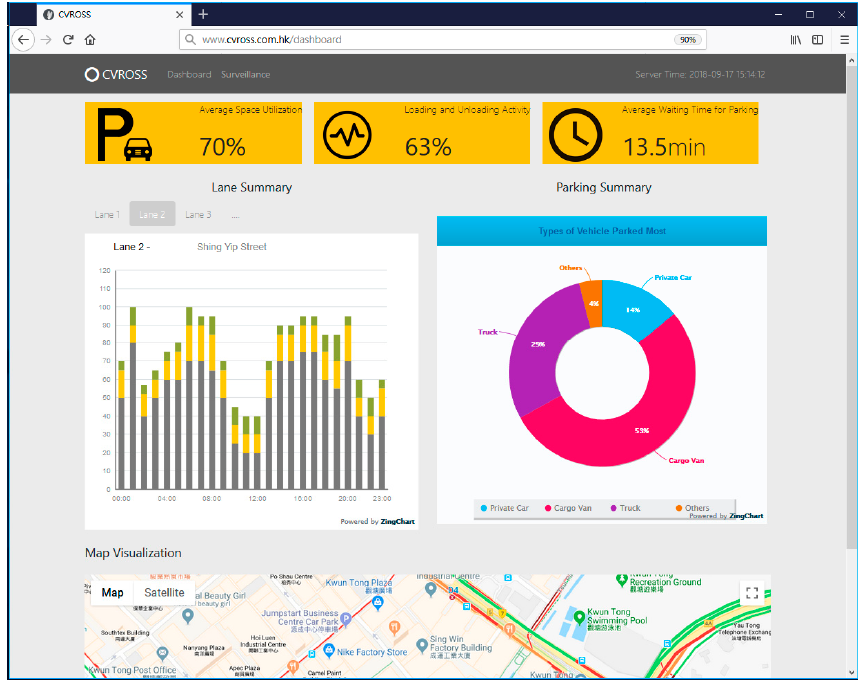
Figure 18. Main dashboard of the CVROSS.